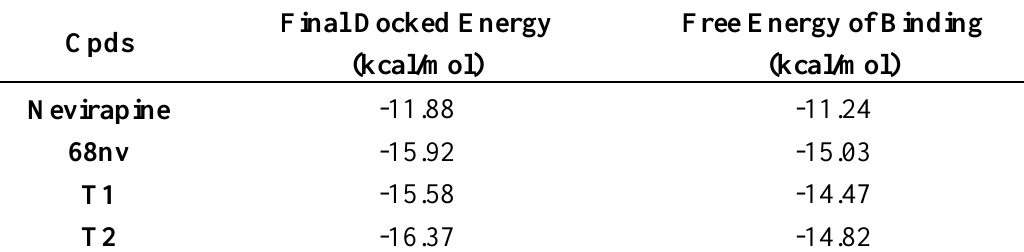
Table 3 . The docked energy and free energy of binding (kcal/mol) of T1 and T2 as compared with nevirapine and 68nv .